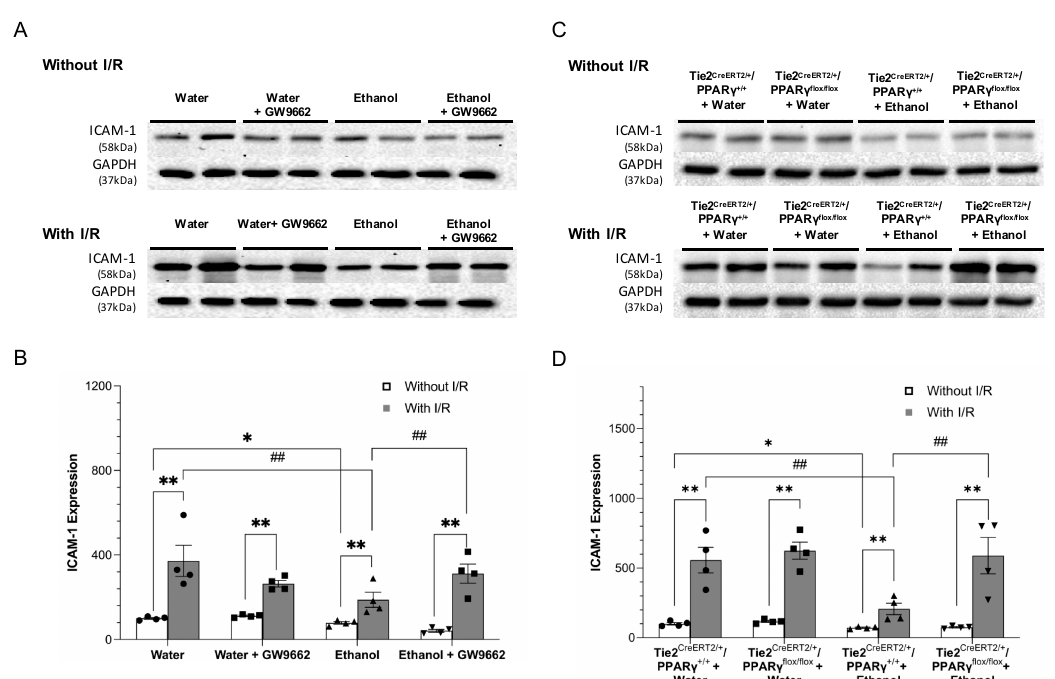
Figure 3. Effect of chronic ethanol consumption on ICAM-1 expression of the cerebral cortex in the presence and absence of GW9662 and endothelial-specific conditional PPAR γ knockout. ( A , C ) Representative Western blots. ( B , D ) Values are means ± SE. * p < 0.05 vs. Water or Tie2 CreERT2/+ /PPAR γ +/+ + Water. ** p < 0.05 vs. Without I/R. ## p < 0.05 vs. Ethanol or Tie2 CreERT2/+ /PPAR γ +/+ + Ethanol. Analyzed using two-way ANOVA with Tukey’s post hoc.